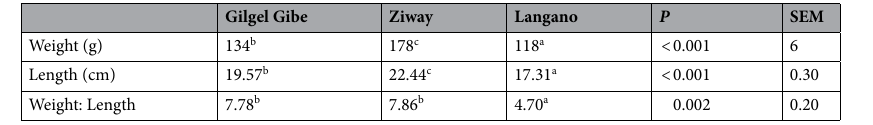
Table 2. Morphometric features of Nile tilapia caught from three lakes in Ethiopia (mean, pooled SEM, n = 20). Different superscripts within a row indicate significant differences at P <